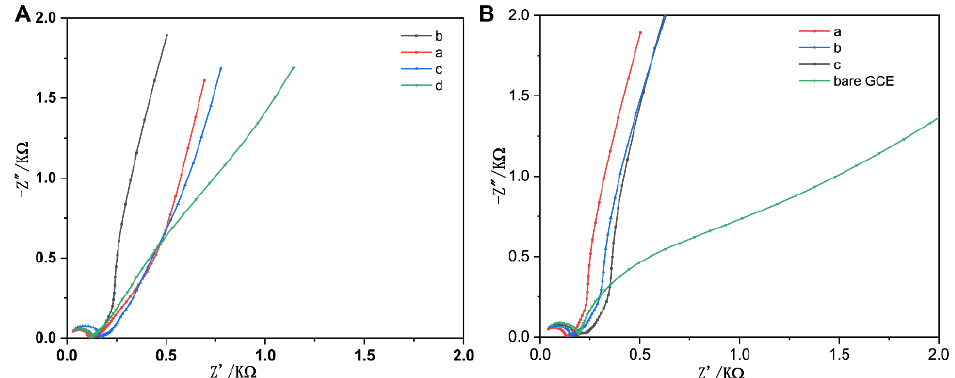
Figure 2. Electrochemical impedance spectroscopy (EIS) measurements of ( A ) different volumes of HAuCl 4 · 4H 2 O (a, 200 µ L; b, 400 µ L; c, 1000 µ L; d, 1500 µ L) and ( B ) different amounts of glucose (a, 20 mg; b, 500 mg; c, 1000 mg) for 3D-rGO/AuNPs nanocomposites and bare glassy carbon electrode (GCE).